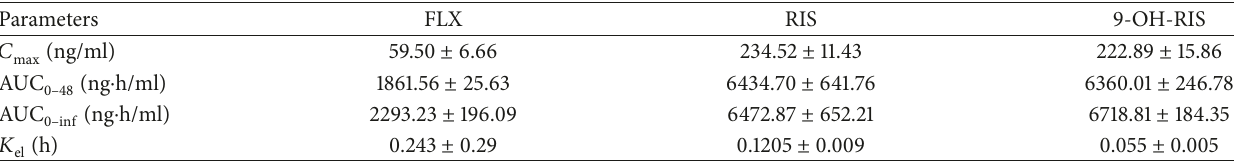
Table 5: Pharmacokinetic parameters of FLX, RIS, and 9-OH-RIS after oral concurrent administration of FLX and RIS to rats.